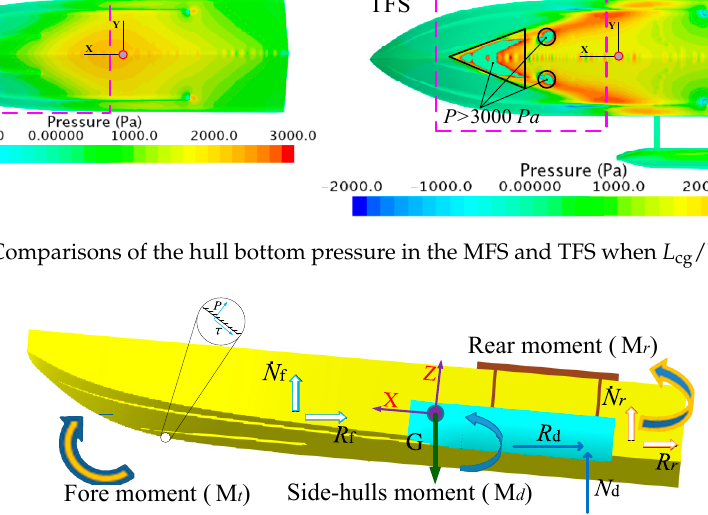
Fore moment  M t  Figure 18. Forces and moment acted on the hull surface in the TFS. Figure 18. Forces and moment acted on the hull surface in the Figure 18. Forces and moment acted on the hull surface in the TFS.